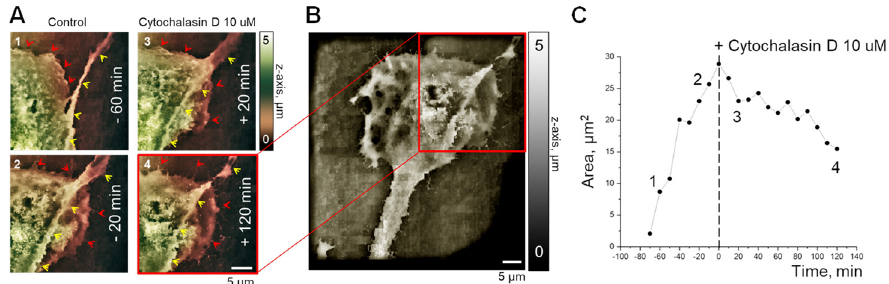
Figure 1. Scanning Ion Conductance Microscopy (SICM) analysis of human podocyte morphology in response to cytochalasin D treatment. ( A ) Representative scans of podocyte lamellipodia (red arrows) and filopodia (yellow arrows) at different time points (60 and 20 min before (1–2) and 20 and 120 min after (3–4) cytochalasin D (10 µm) application; scan area 30 µM × 30 µM). ( B ) Expanded topographical map showing the complete podocyte from a after the application of cytochalasin D (scan area 60 µM × 60 µM). ( C ) Timeline of changes to the podocyte foot process area during normal migration and after cytochalasin D application. Numbers 1–4 represent time points shown in ( A ). As seen in this summary, cytochalasin D completely stopped the migration of the podocyte filopodium.